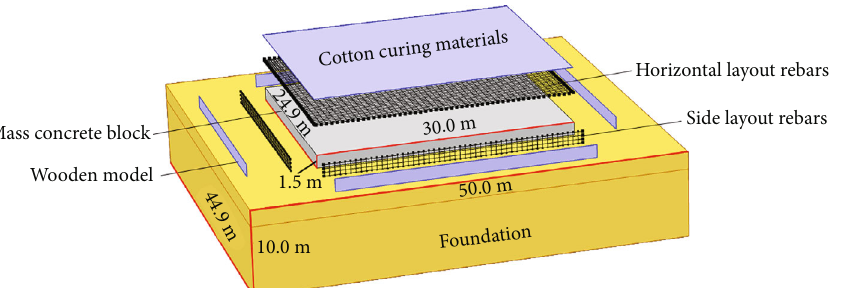
Figure 3: Geometry model of mass concrete.